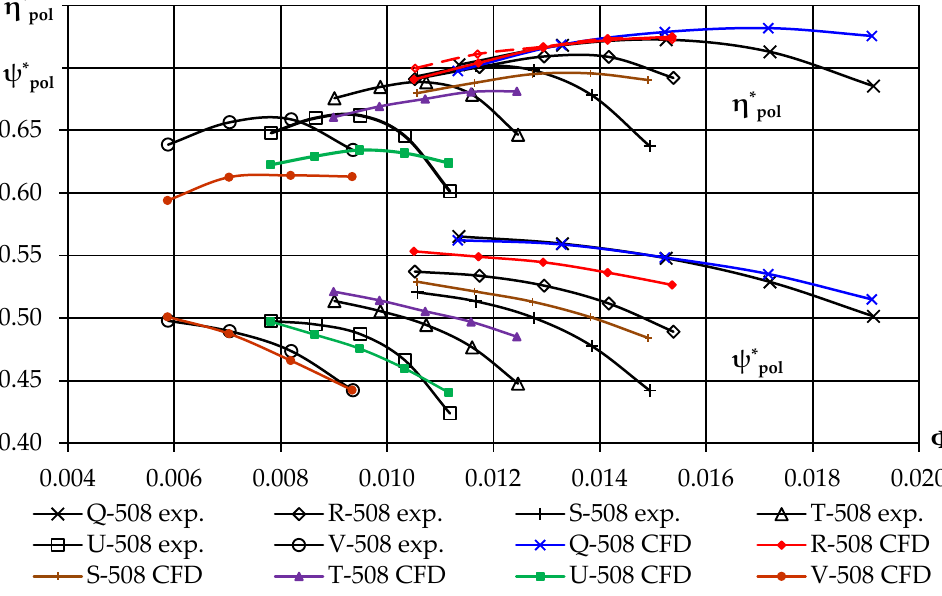
Figure 7. Comparison of experimental and calculated characterizations of the model stages.